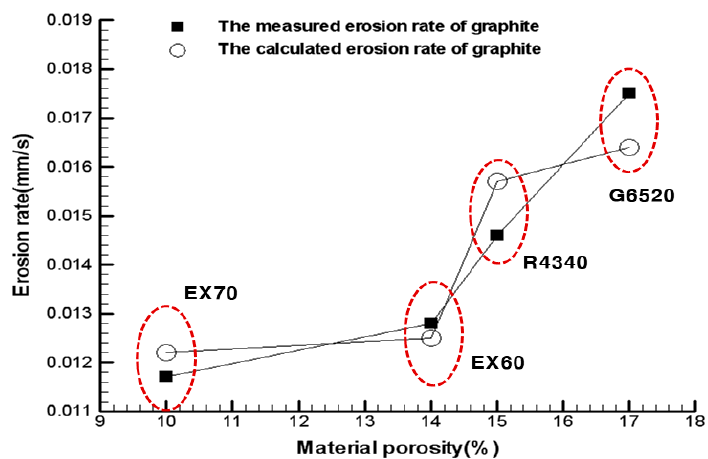
Figure 12. Comparison of measured and calculated erosion rates in terms of the porosity of graphite.